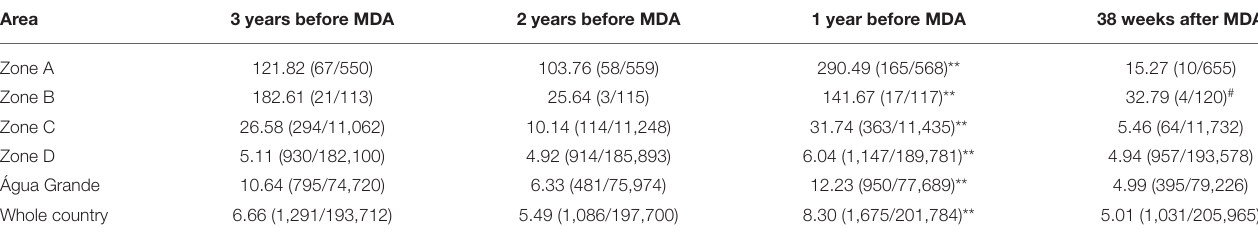
TABLE 3 | Malaria incidences ( ‰ ) * (cumulative malaria cases/population) pre- and post-MDA.